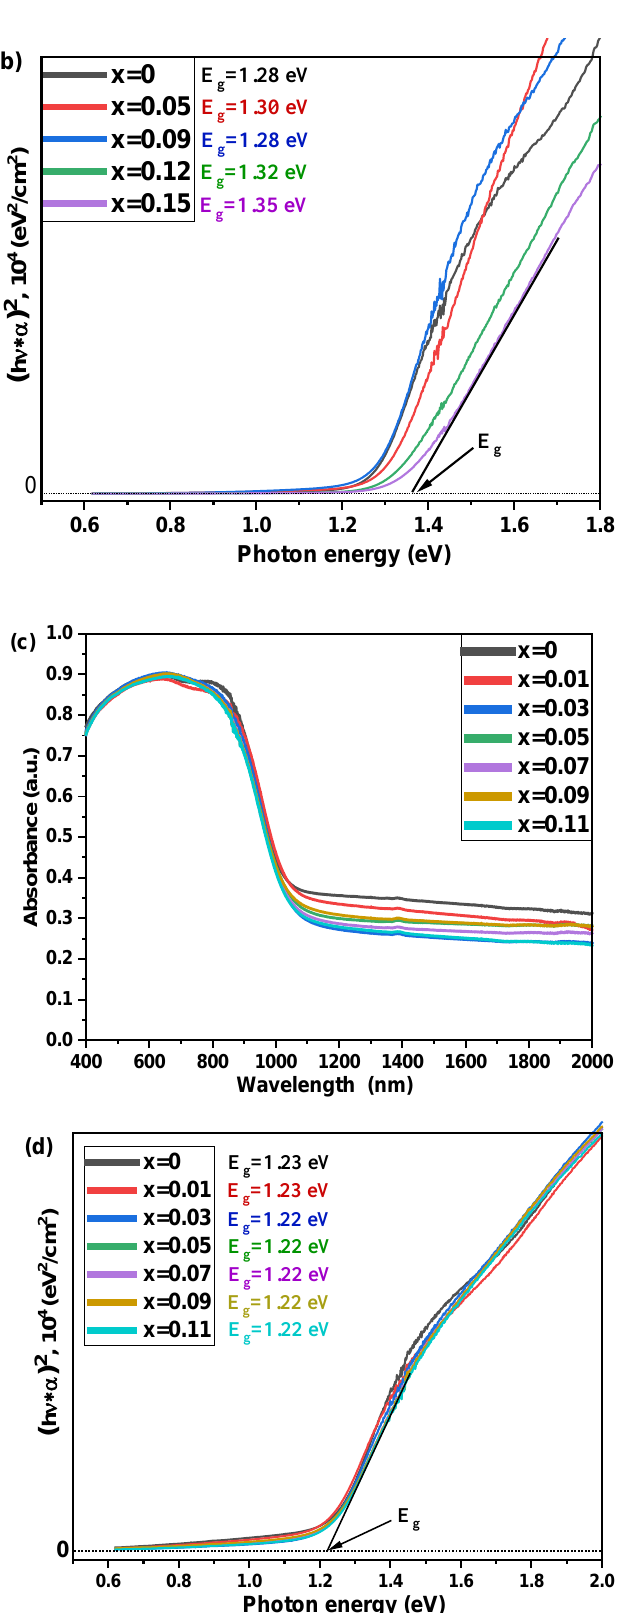
Figure 4. ( a ) Optical absorption spectra and ( b ) Tauc plots of the absorbance data for RS samples and ( c , d ) for SS samples, respectively.